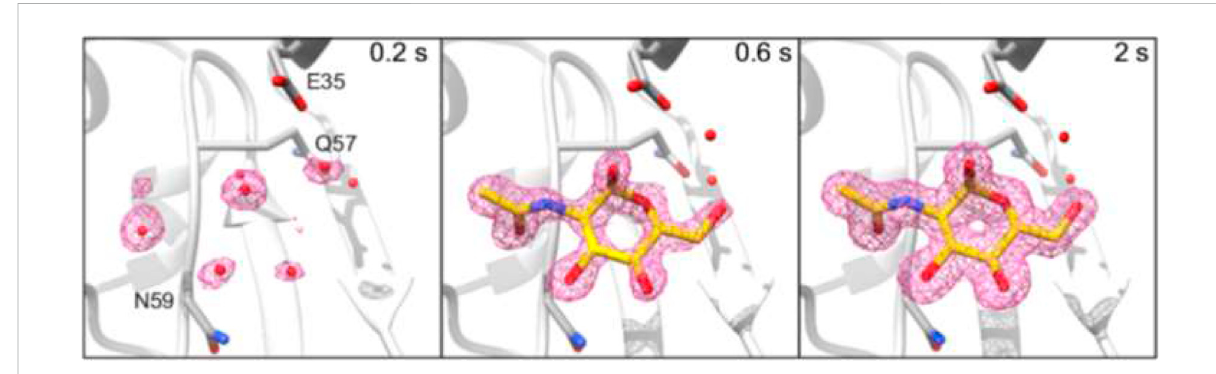
FIGURE 8 2mF – DF o c electron density maps for HEWL-GlcNAc Structures, displayed at±1 TheGlcNAcmoleculefromthe2 stimepointstructurewasusedtocarvethe200 mstimepointmap.Allmapsareat1.45 Åresolution.Adaptedwith permission from: (Butryn et al.,